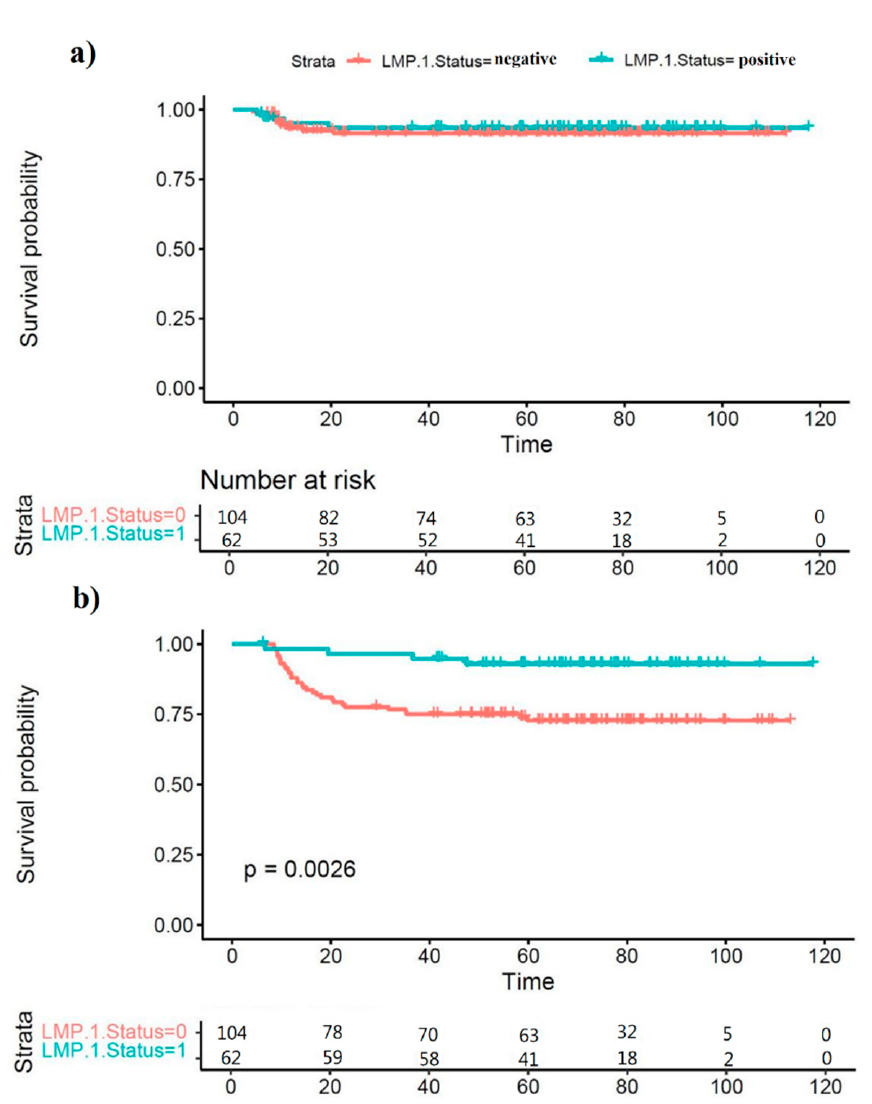
Figure 1. Overall survival ( a ) and event-free survival ( b ) for 166 subjects with cHL, by EBV status. In a Cox regression model, positive LMP1 status was associated with a significantly reduced risk of treatment failure (HR = 0.21, p = 0.005, Figure 2). EBV status retained a similar effect size and statistical significance in models adjusting for age, sex, and stage. We defined stage in two groups, early (stages I/IIA) and advanced (IIB/III/IV), based on risk stratification and treatment management guidelines [86,87]. Patients within the early group had reduced risk of failure compared to advanced stages, but this difference was not statistically significant ( p = 0.45), and EBV status remained the most predictive factor. Age also has a negative effect on patients’ outcome, with older patients having poorer outcomes, but this was not statistically